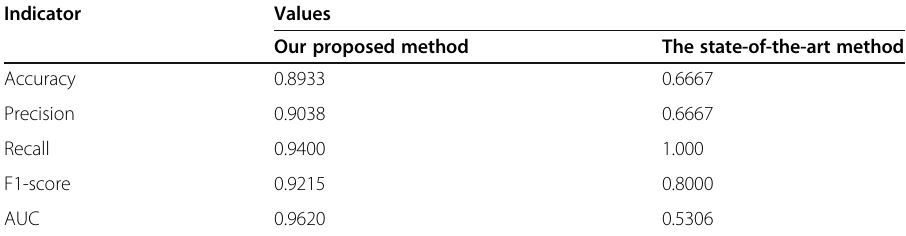
Table 5 Comparison results of distinguishing performance with the state-of-the-art method Indicator Values Our proposed method The state-of-the-art method Accuracy 0.8933 0.6667 Precision